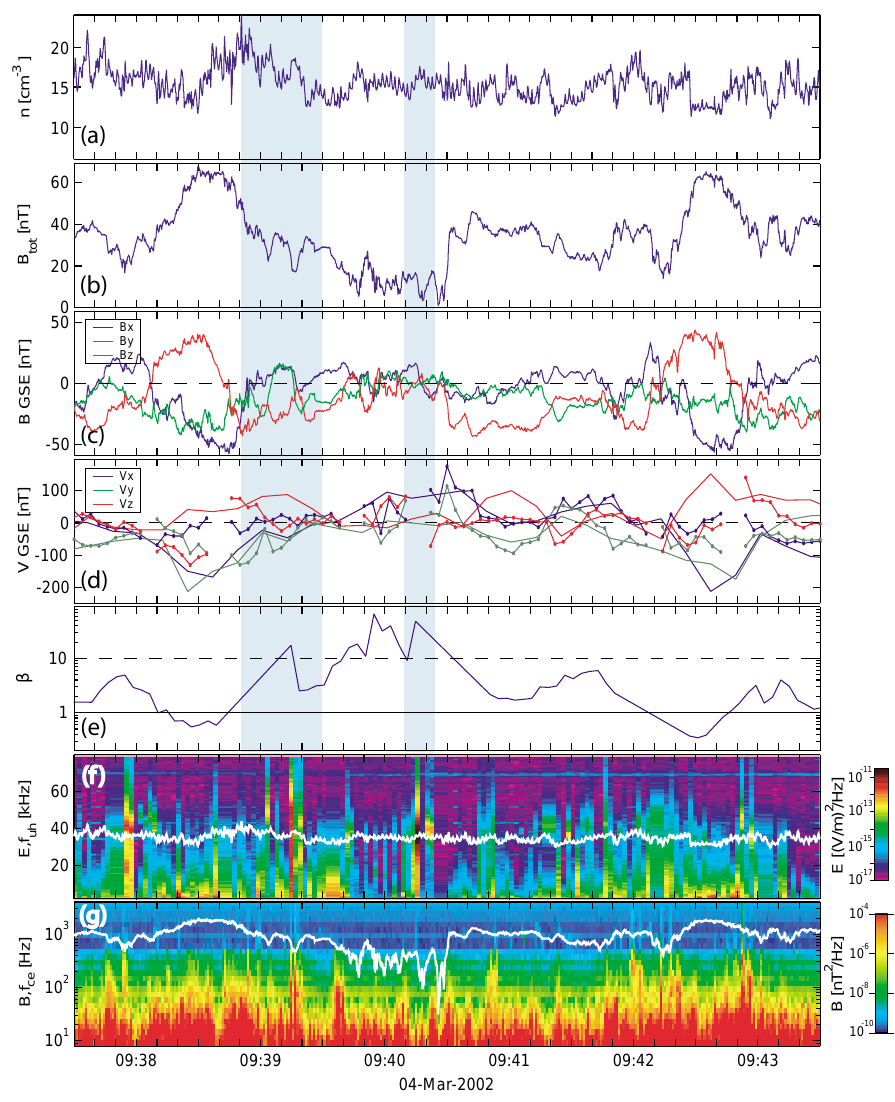
Fig. 3. Detailed view of the cusp/exterior cusp region observed by Cluster 3 during period 09:38–09:41 UT. Panels from top to bottom show: (a) plasma density derived from the spacecraft potential, (b, c) the magnetic field magnitude and components, (d) ion flow velocity (full from HIA, solid line, and E × B , dotted line), (e) plasma β , (f) spectra of the electric field in 2–80kHz range and the upper hybrid frequency, (g) spectra of the magnetic field in 8–4000Hz range and the electron-cyclotron frequency. The shaded regions mark the time intervals presented in Fig.